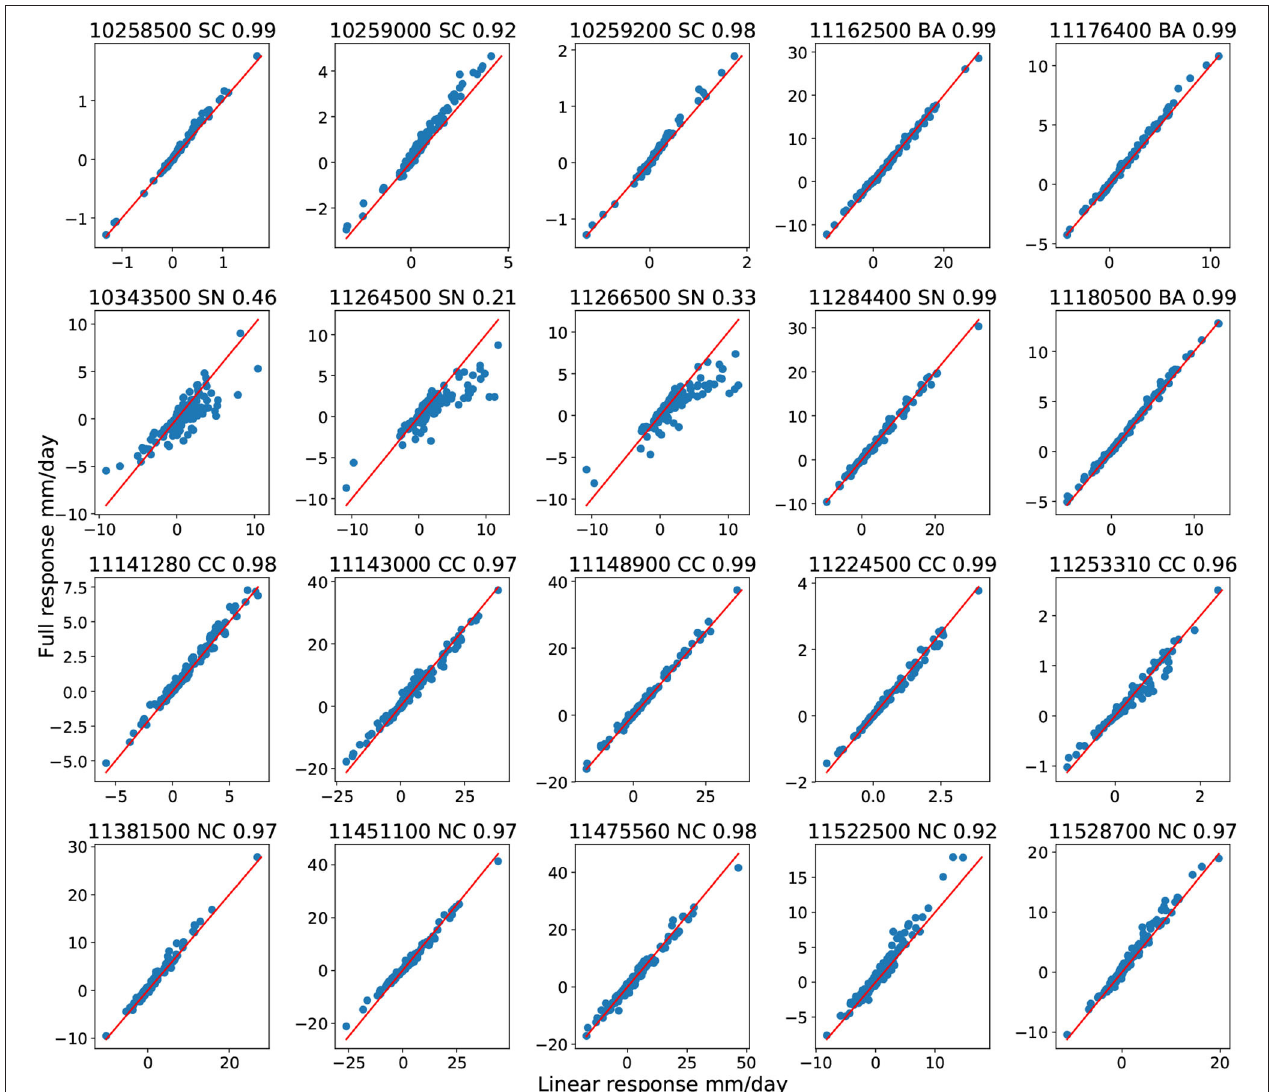
FIGURE 10 | Full response and linear response for all basins with CanESM2